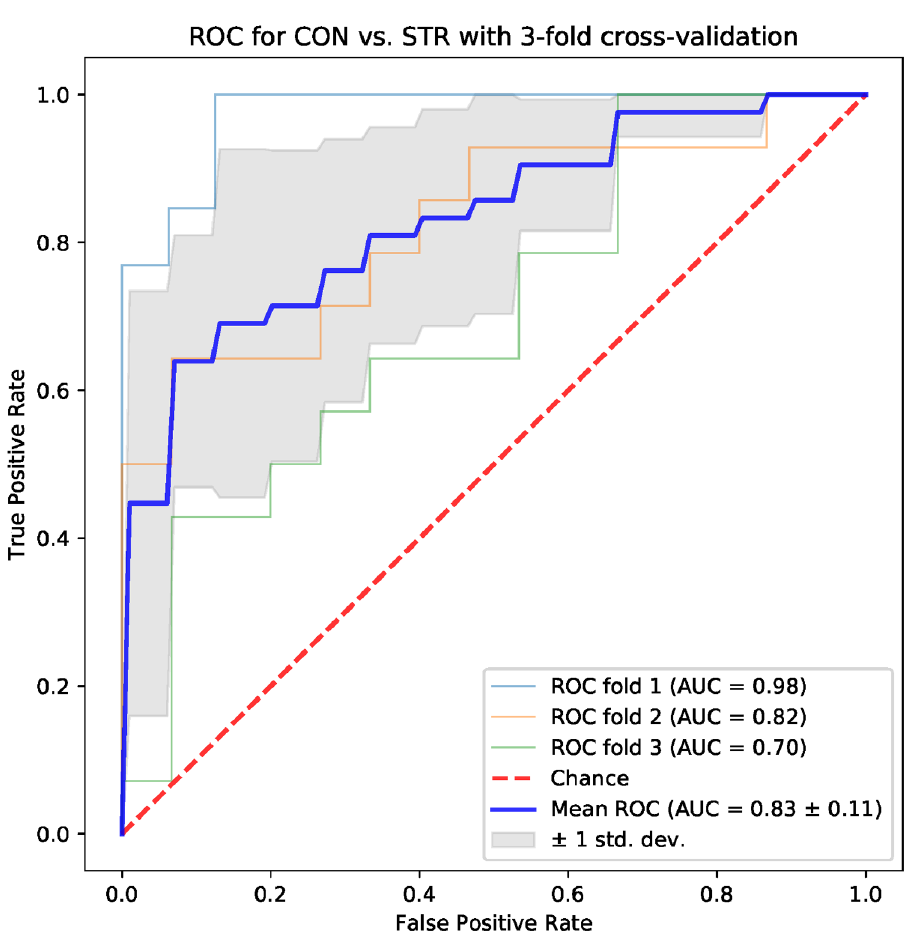
Fig 6. Results for the model trained with four topological parameters: Triangle height, triangle location, number of intervals, length sum